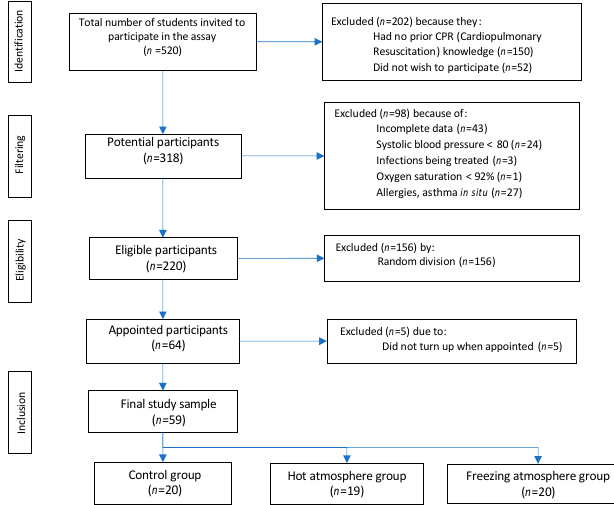
Figure 1. Flow chart of the selection of participants for this study.